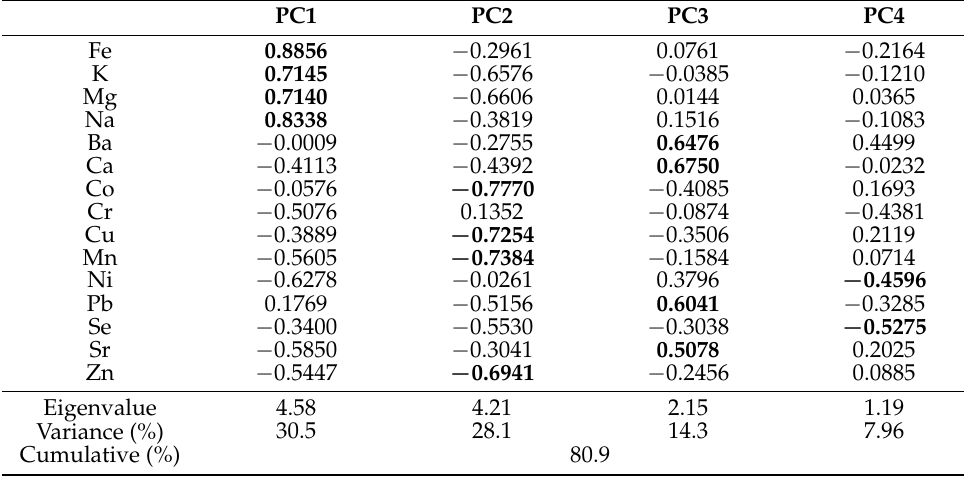
Table 3. Loadings, eigenvalues and variances of the significant principal components.